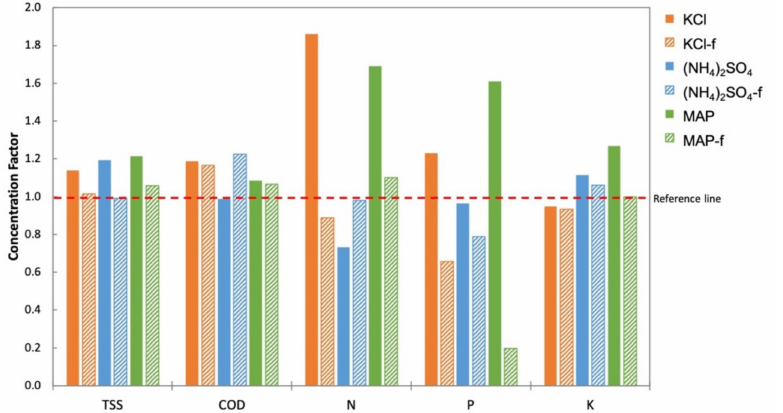
Figure 12. Concentration factor (final concentration/initial concentration) of total suspended solid (TSS), chemical oxygen demand (COD), and nutrients (nitrogen (N), phosphorus (P), and potassium (K)) in An-POME feed by various fertilizer